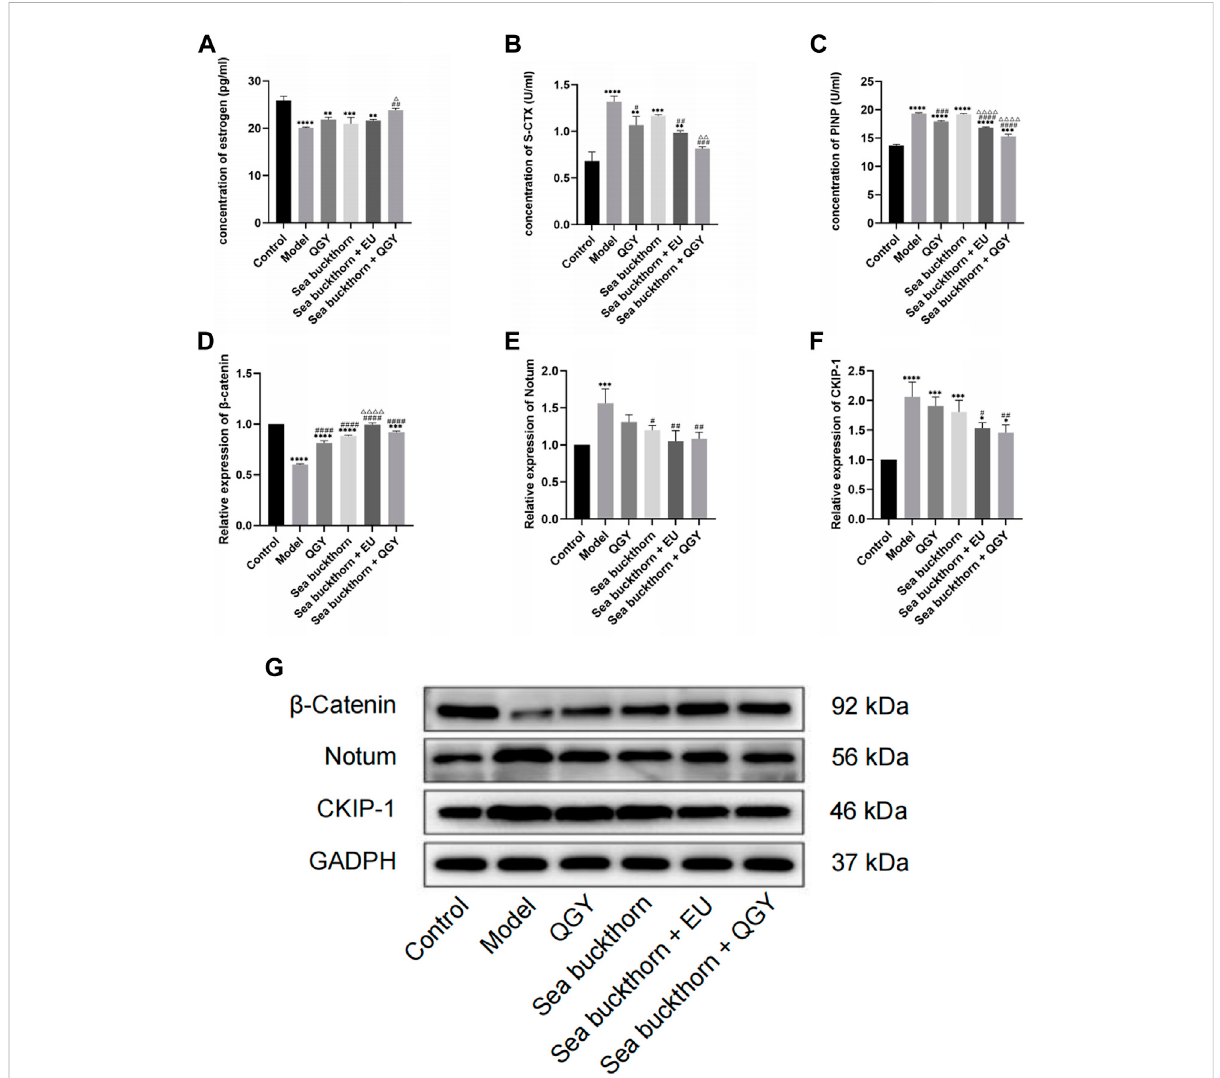
FIGURE 3 (A – C) The levelsofestrogen, S-CTXand PINP. (D – G) theexpression of β -catenin, Notum, and CKIP-1. *,**,***, and****, p < 0.05, p < 0.01, p < 0.001, and p < 0.0001, respectively, in comparison with the normal control group; #, ##, ###, and ####, p < 0.05, p < 0.01, p < 0.001, and p < 0.0001respectively,incomparisonwiththePMOPmodelgroup; △ , △△ , △△△ ,and △△△△ , p < 0.05, p < 0.01, p < 0.001,and p < 0.0001respectively, in comparison with the QGY